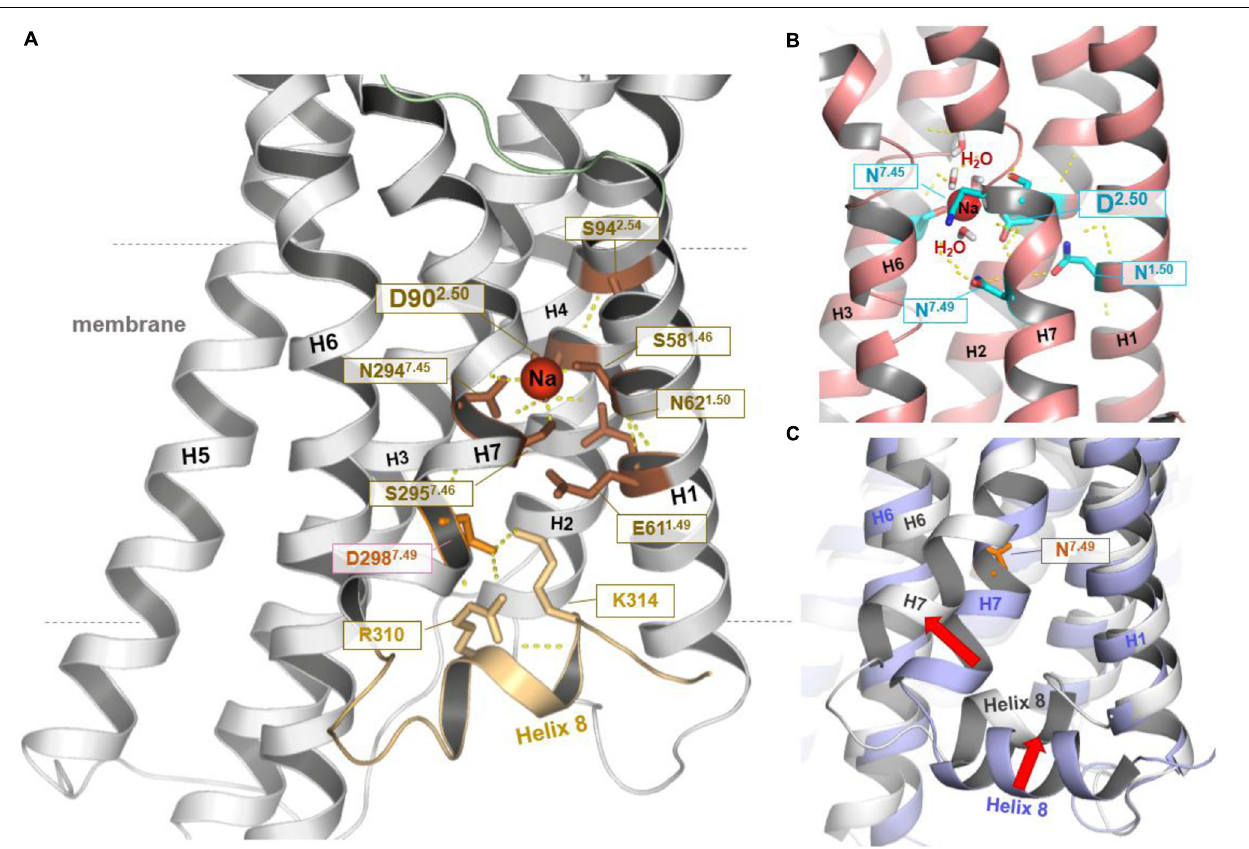
FIGURE 2 | Structural–functional specificities observed in the hMC4R model. In the resulting hMC4R homology model (A) formation of a stable sodium binding pocket constituted by hydrophilic amino acid residues Ser 1 . 46 (Ser58, TM1), Asp 2 . 50 (Asp90, TM2), Ser 7 . 46 (Ser295, TM7), and Asn 7 . 45 (Asn294, TM7) was observed (dotted yellow lines indicate potential hydrogen bonds), surrounded by further hydrophilic residues in TM1 (Asn62, Glu61) and in TM2 (Ser94). Sodium binding under participation of the highly conserved amino acid Asp 2 . 50 was already reported for the determined structures of protease-activated receptor (PAR) 1 [PDB entry 3VW7 (Zhang et al., 2012)] and PAR2 [PDB entry 5NDD (Cheng et al., 2017)], or as shown in (B) for the high-resolution structure of the A2AR [PDB entry 4EIY (Liu et al., 2012)]. Potential water molecules additionally surrounding the Na + ion in a cluster like arrangement. We further note that during our MD simulations (C) the C-terminus of TM7 moved ( ∼ 5.6 Å) toward the membrane (red arrow, MC4R white backbone) in comparison to the template structure of TM7 (blue backbone-ribbon of S1PR1). This process was accompanied by an inward displacement of H8 (red arrow). This motion resulted in potential polar interactions including salt bridges between positively charged residues in H8 and a negatively charged side chains in TM7 (Asp298) below to the sodium binding pocket (shown in A ). In the template structure ( C , blue backbone) H8 localization and the position of residue 7.49 are similar to the commonly observed features in determined class A GPCR